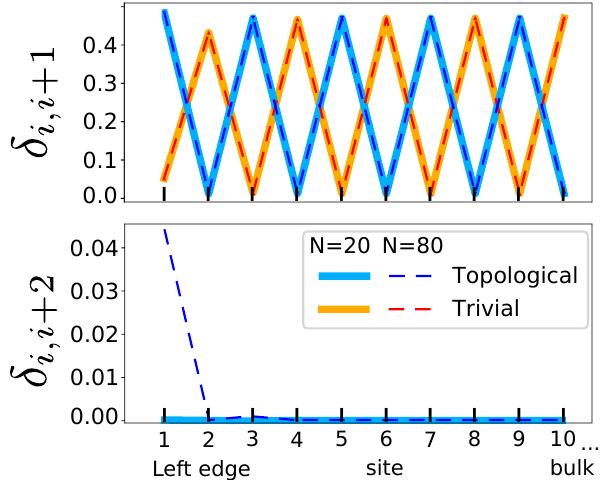
Figure 7. DIs δ i , i + 1 and δ i , i + 2 of the bipartite lattice with 20 and 80 atoms (only 10 sites are shown). The index δ i , i + 2 for trivial insulators is zero